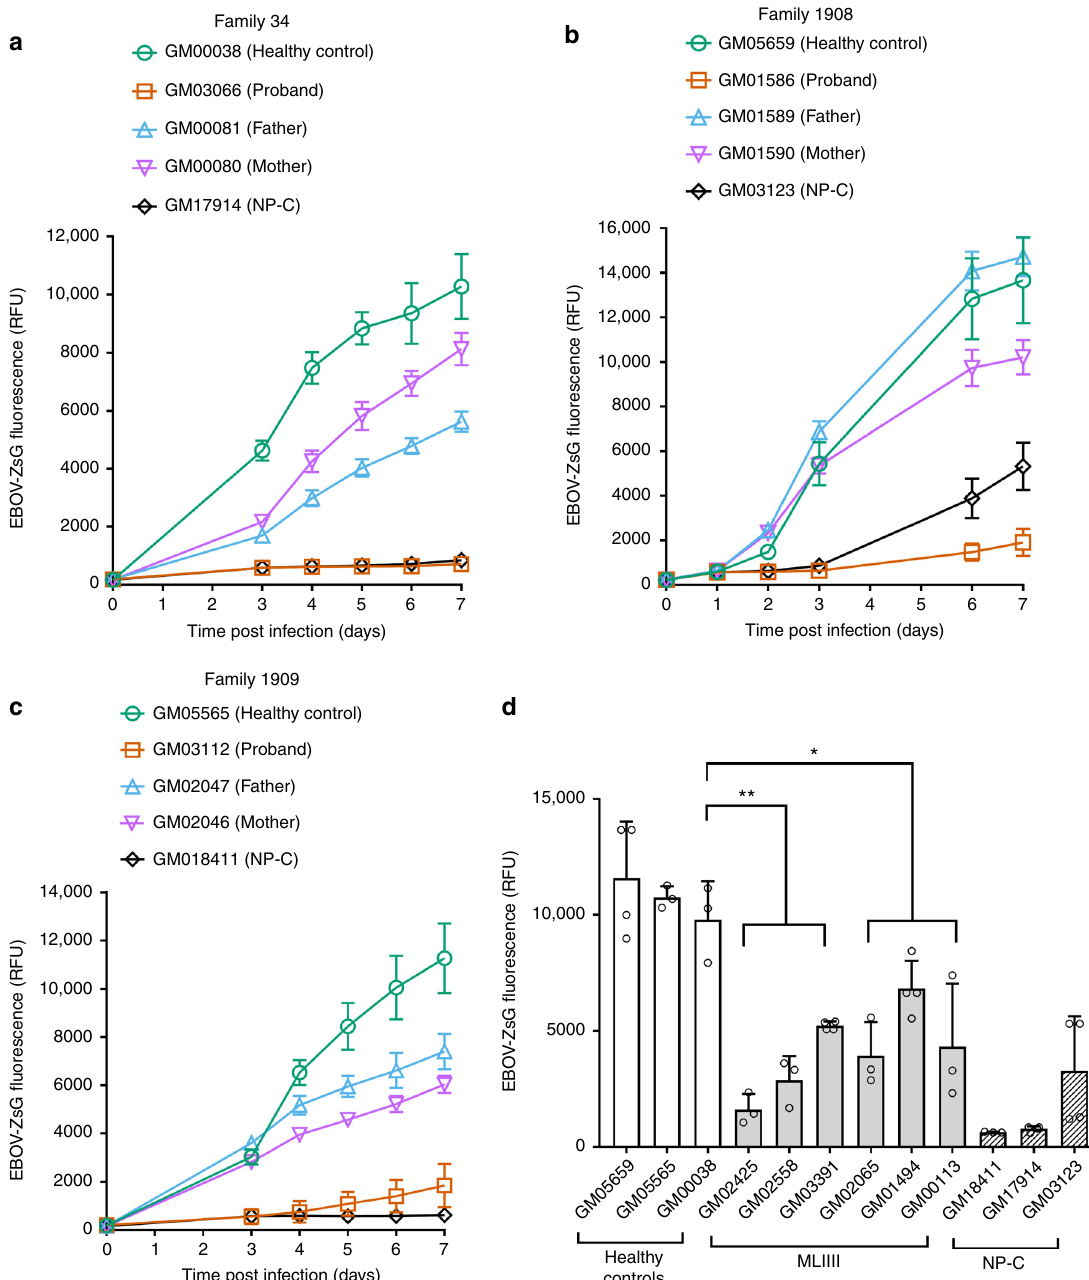
Fig. 4 Fibroblasts from mucolipidosis patients do not ef fi ciently support EBOV infection. Fibroblast cells were infected with the EBOV-ZsG reporter virus at an MOI of 1 and ZsG fl uorescence was followed over time. a Family 34, b family 1908, c family 1909. Data represent the mean ± s.d. of eight biological replicates. A representative of at least two independent experiments is shown. d Fibroblasts from MLIII patients, compared to cells from healthy controls and NP-C patients. ZsG fl uorescence was measured 7 days post infection. Data represent the mean ± s.d. from at least three independent experiments. Statistical analysis was performed with a two-tailed Student ’ s t -test with signi fi cance shown as ** P ≤ 0.005, * P ≤